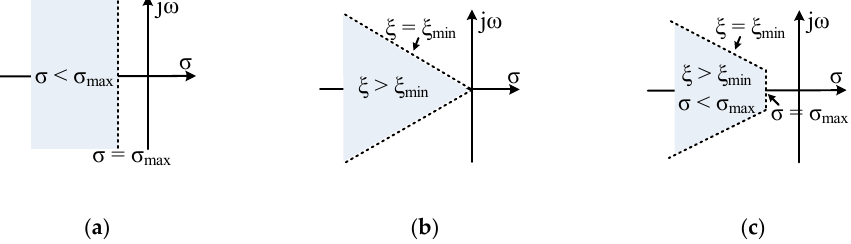
Figure 2. Region of eigenvalue location based on the different stability and performance objectives. ( a ) Region in the left-side of the s-plane where σ < σ max ; ( b ) a wedge-shaped sector in the s-plane where ξ > ξ min ; ( c ) a D-shaped sector in the s-plane where σ < σ max & ξ > ξ min